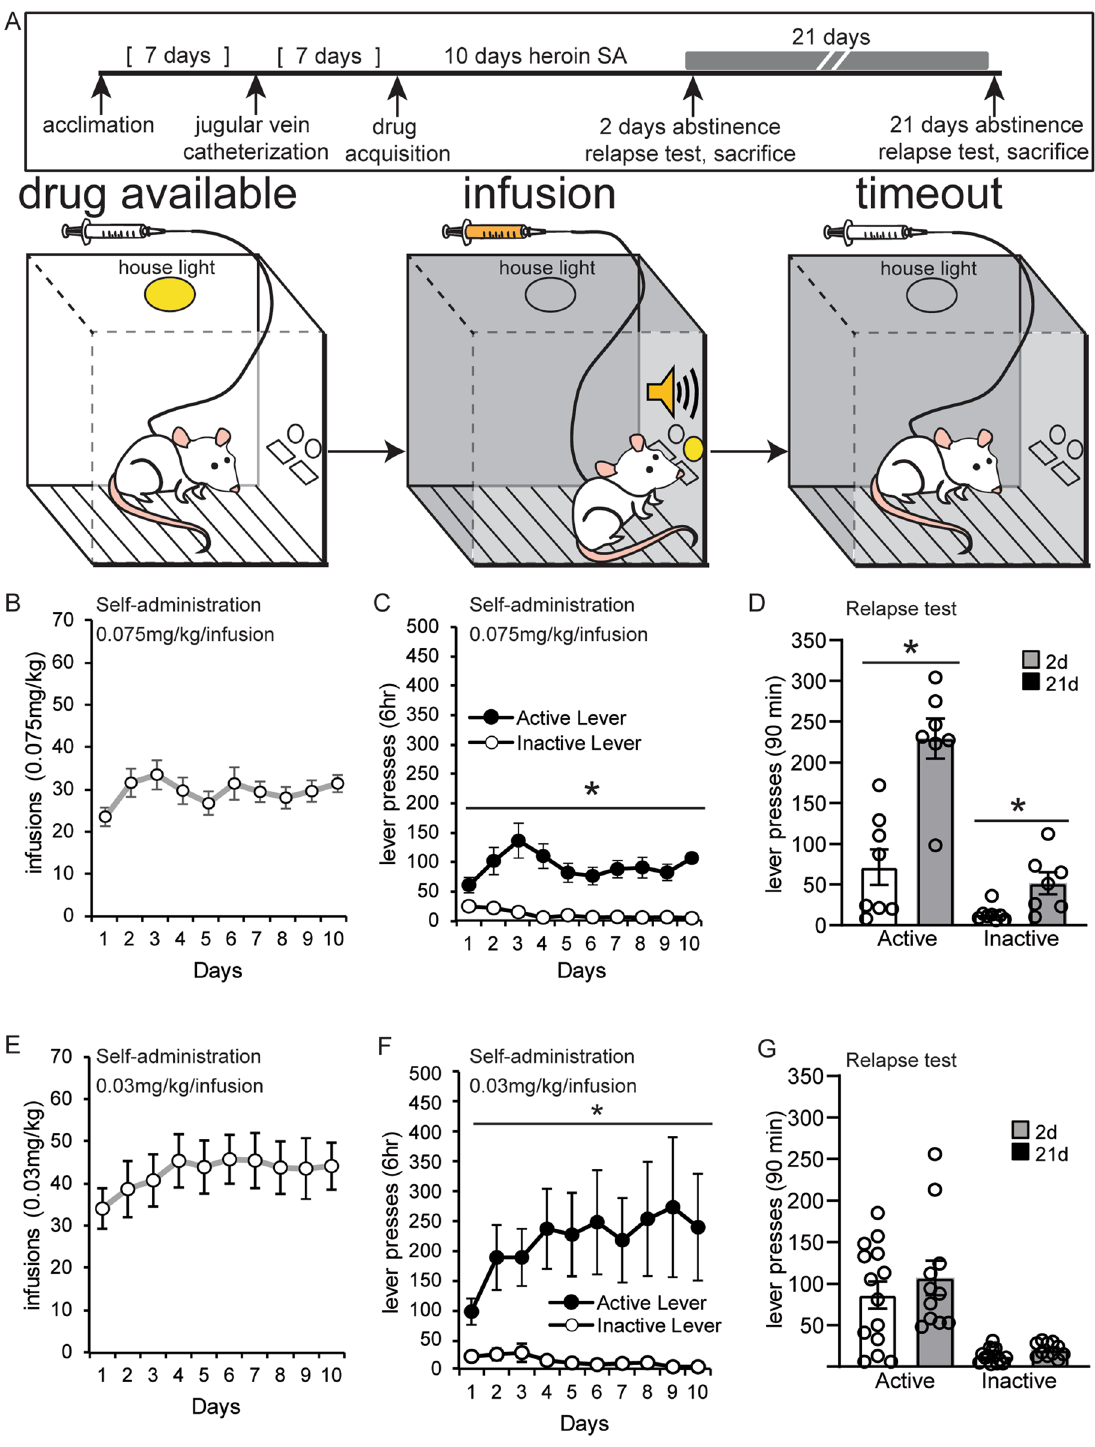
Figure 1. Establishment of a rat incubation of opioid craving protocol with discrete drug cues. ( A ) An overview of the protocol to measure drug seeking after abstinence from self-administration of heroin paired with discrete drug cues. Animals underwent surgery for jugular vein catheterization then acquired heroin self-administration in 6-h daily sessions for 10 days. A relapse test was performed after 2 or 21 days of abstinence from heroin. During acquisition, the house light signaled the availability of the drug. Active lever pressing resulted in illumination of a light above the active lever and an auditory cue during drug infusions. A 20 s (s) timeout period followed each infusion, in which no lights were illuminated in the chamber. ( B , C , E , F ) The number of infusions and lever presses during heroin self-administration at a 0.075 mg/kg/infusion dosage ( B , C ) and a lower 0.03 mg/kg/infusion dosage ( E , F ). Error ± standard error of the mean (SEM). ( D , G ) Lever pressing during the relapse test after forced abstinence from the 0.075 mg/kg/infusion dosage ( D ) and the 0.03 mg/kg/infusion dosage ( G ). * p <